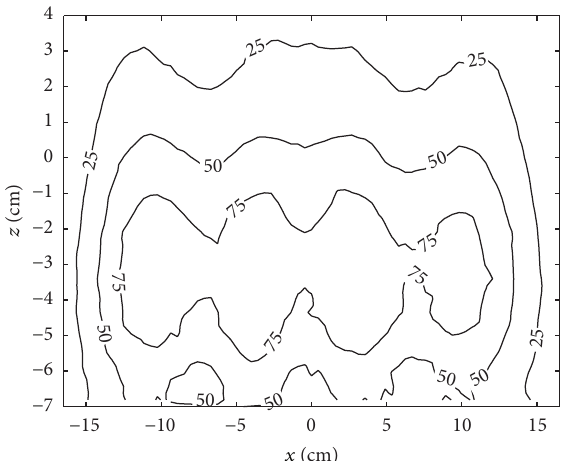
Figure 11: Contours of SAR distribution in the plane parallel to the applicator aperture. The plane is located 1cm inside the phantom of the treated tissue and SAR values are given as percentages of the highest value in the considered plane.